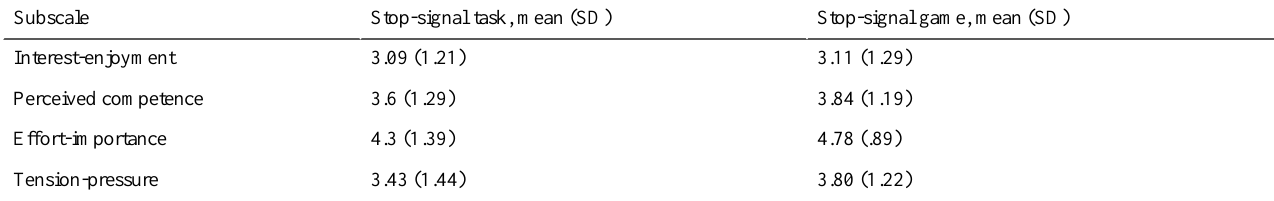
Stop-signal game, mean (SD)Stop-signal task, mean